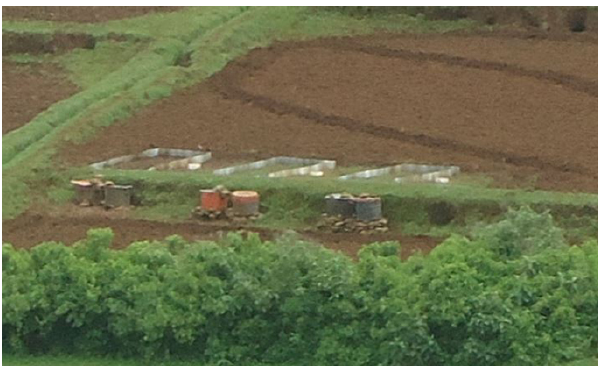
Figure 2. Groups of three runoff plots setup in the downslope posi- tion along Transect 2. Water storage tanks are positioned below the plots, on the downslope side of the terrace edge. Dark brown lines above runoff plots are traditional conservation practices (drainage ditches) constructed by farmers to channel out excess water from